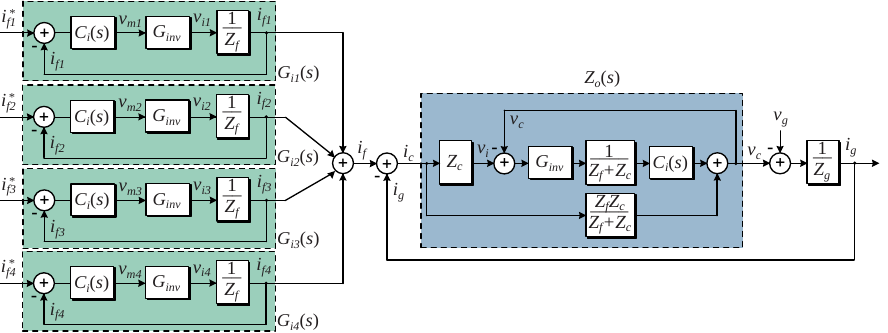
Figure 10. Norton model of whole